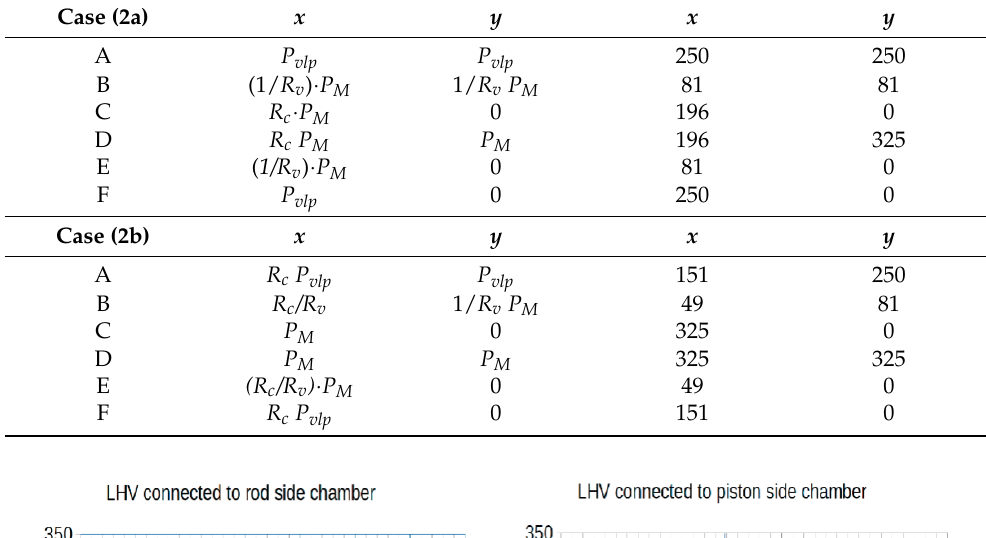
Table 2. List of critical points in the diagrams in Figure 4 in bar. Figure 3. Steady-state operating curves P 1 = f ( P 3 ) for the two cases (2a) and (2b). Point A corre- sponds to the LHV opening point and point B to the LHV set pressure.